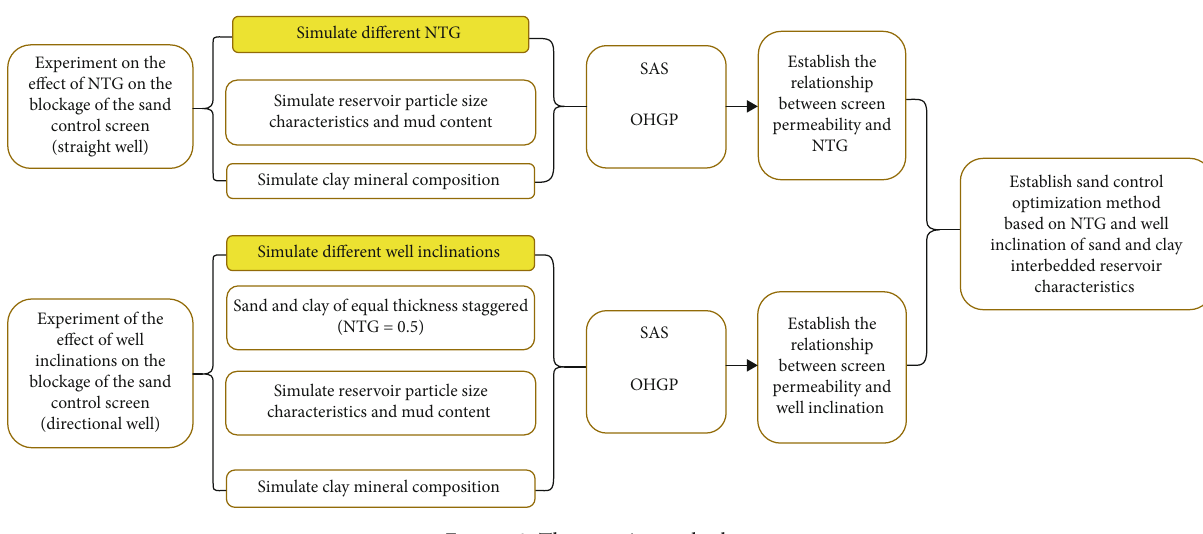
Figure 8: The experimental scheme.